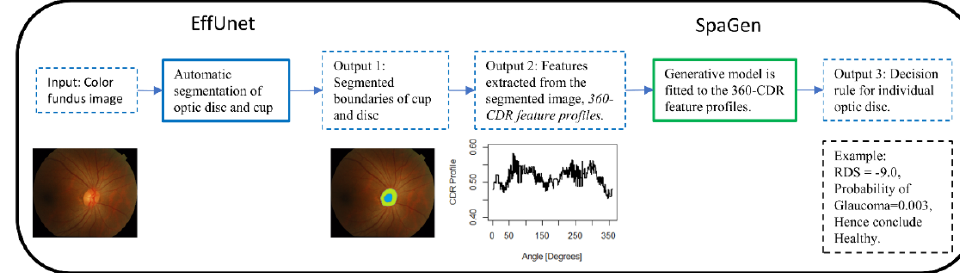
Figure 2. Framework of our EffUnet-SpaGen network. EffUnet is explained in Figures 3 and 4, SpaGen is explained in Figure 5.